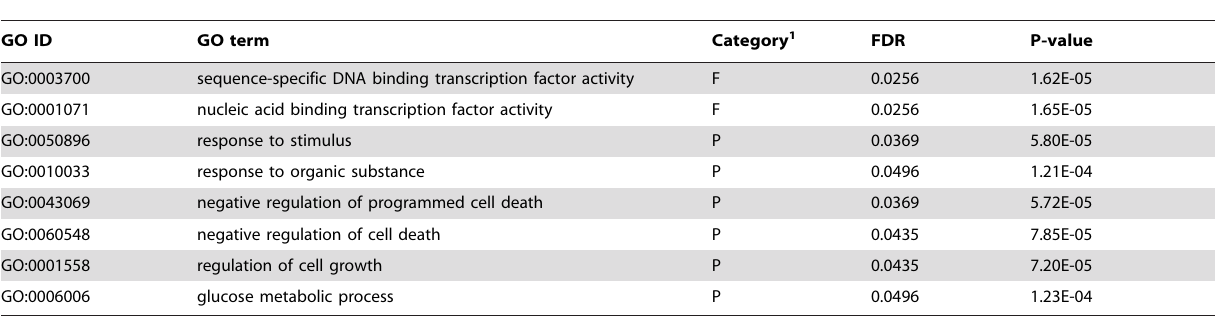
Table 3. Enriched GO terms in response to handling and confinement stress.